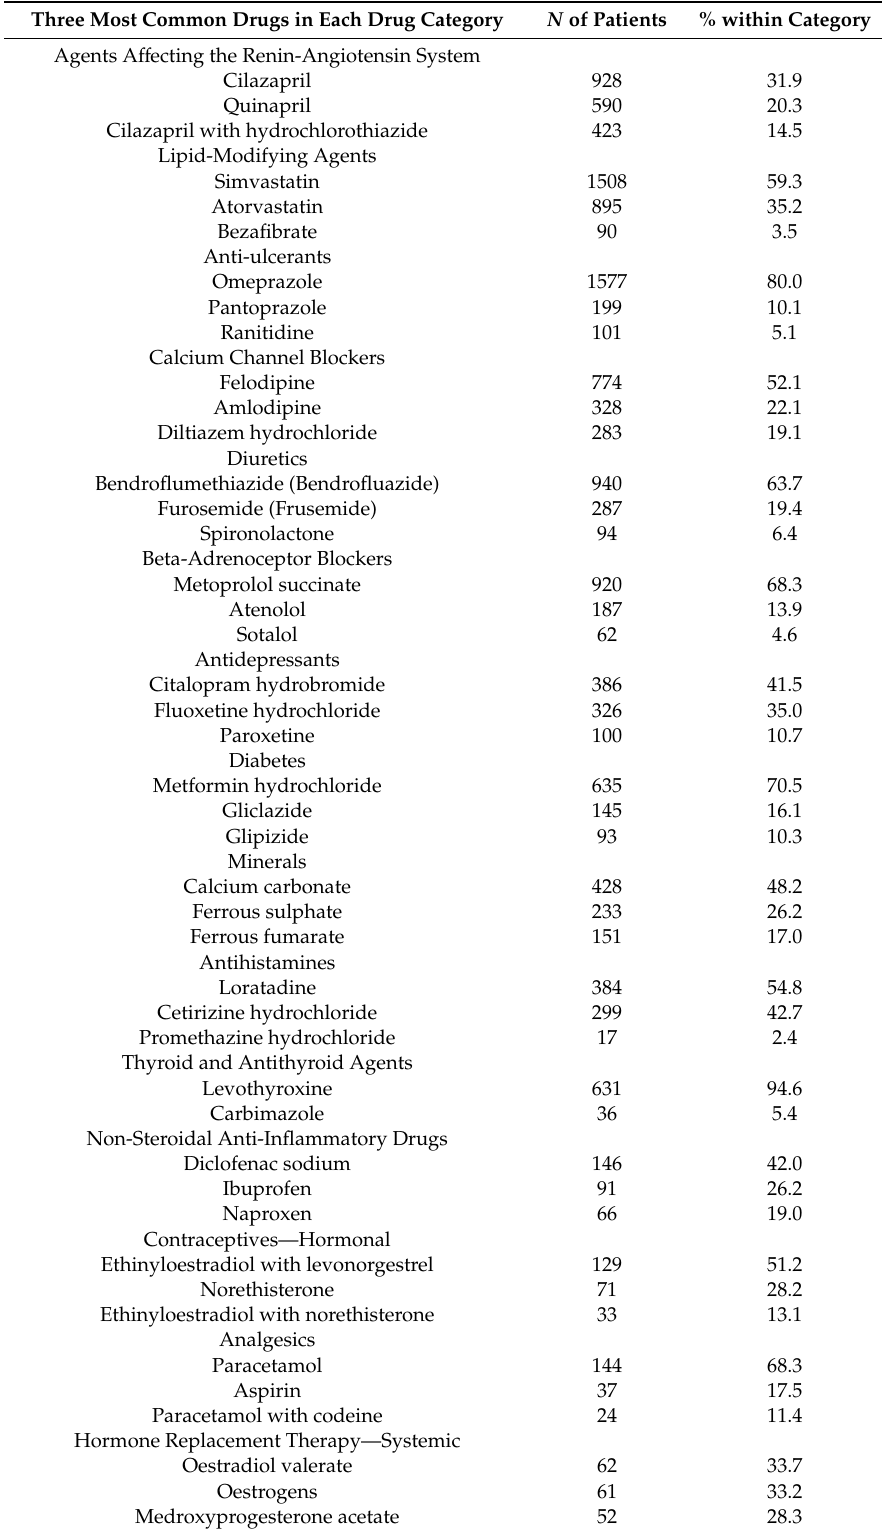
Table 2. Three most common drugs dispensed in each drug category, showing the 15 most common categories of a total of 57 categories. Three Most Common Drugs in Each Drug